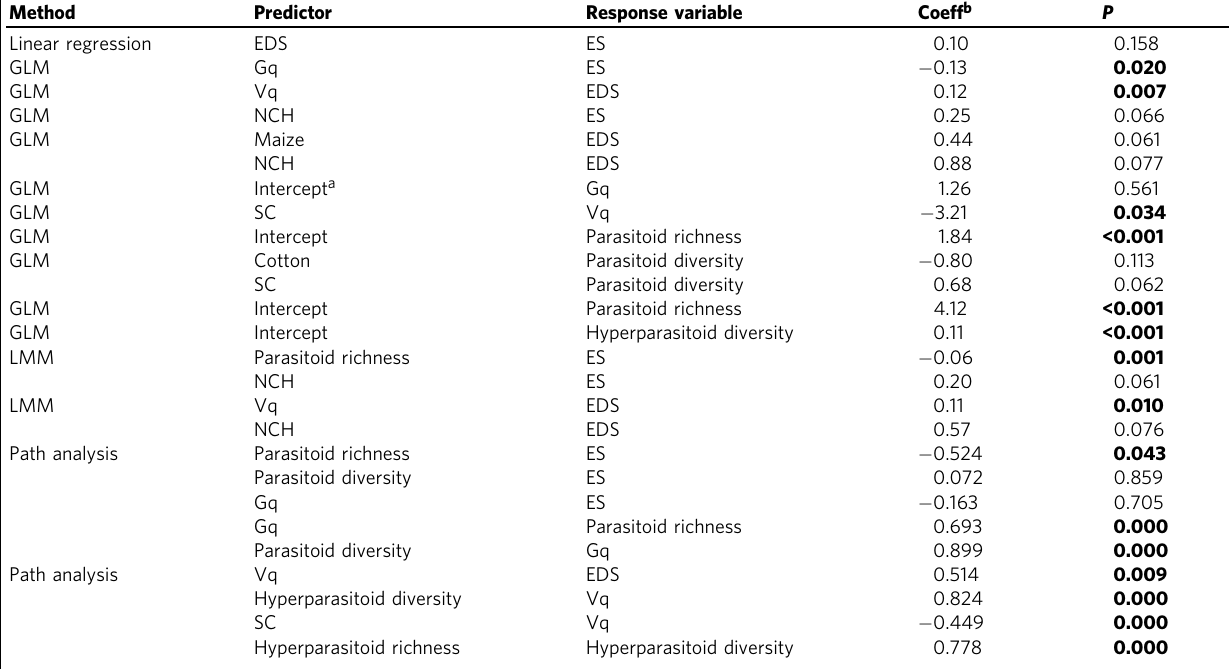
Table 1 Summarized effects of predictors on ecosystem services and food web metrics.